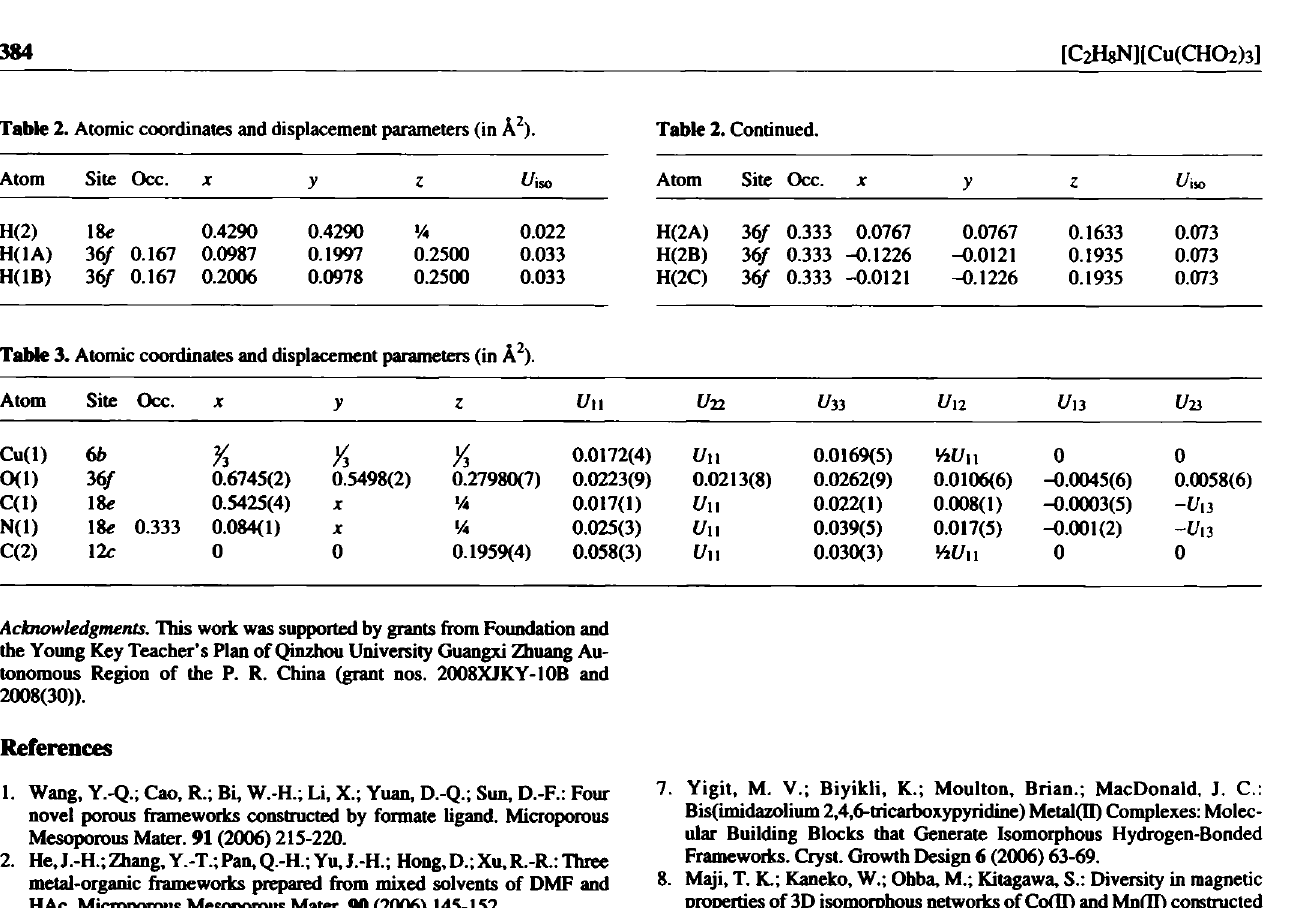
Table 2. Atomic coordinates and displacement parameters (in Â 2 ).